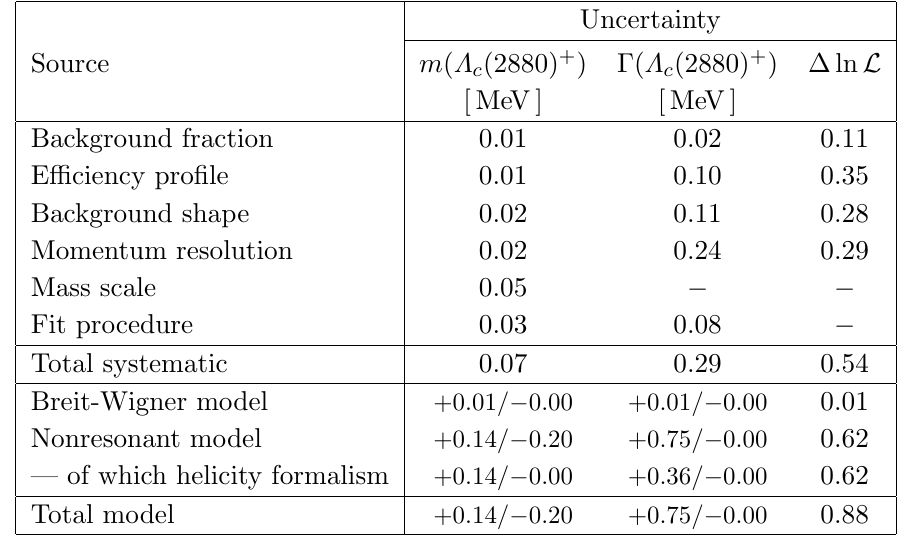
Table 4 . Systematic and model uncertainties on the (cid:3) c (2880) + parameters and on the value of (cid:1) ln L between the 5 = 2 and 7 = 2 spin assignments. The uncertainty due to the nonresonant model includes a component associated with the helicity formalism, which for comparison is given explicitly in the table,